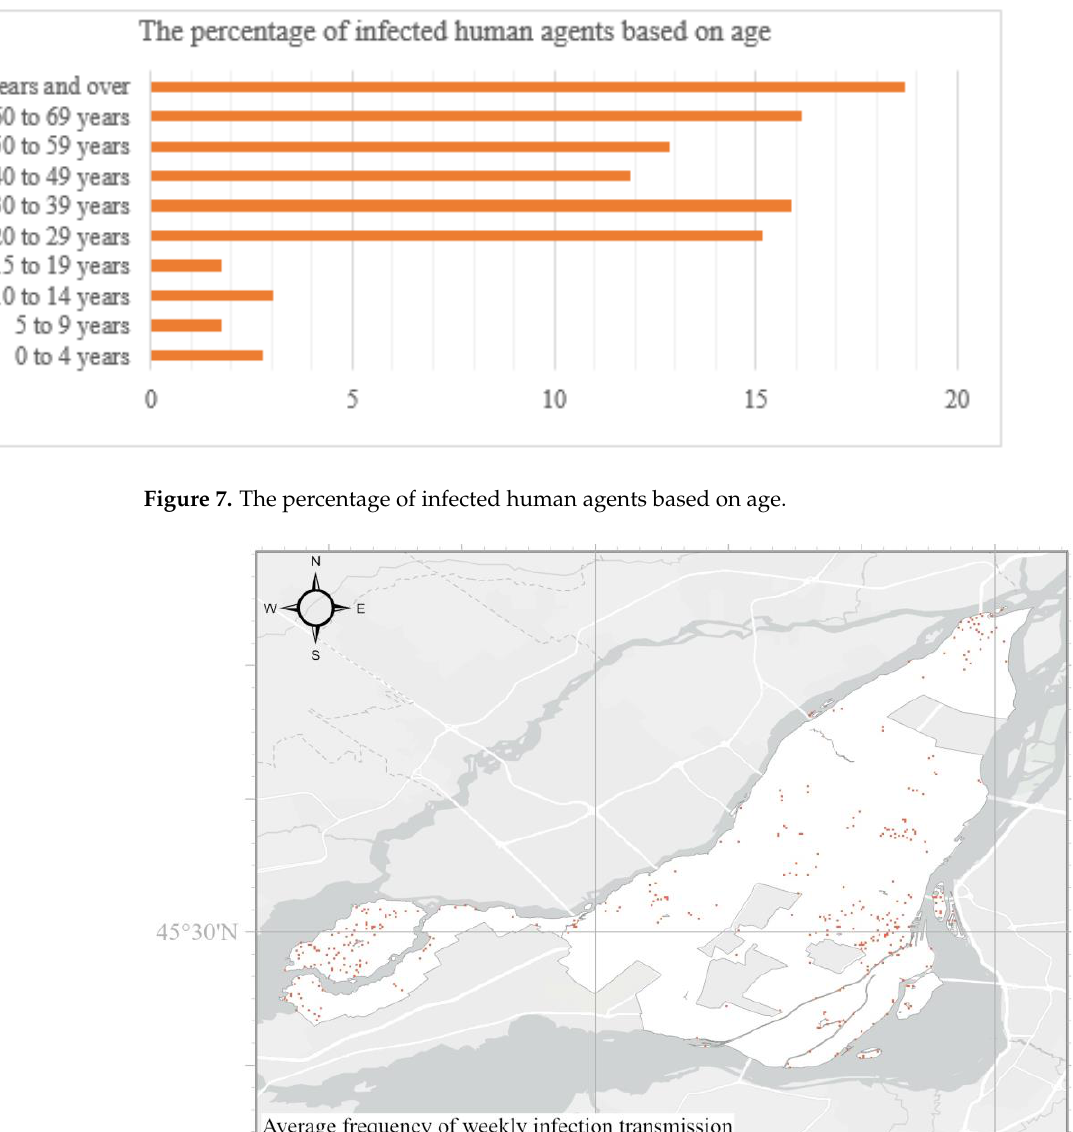
Figure 6. The momentum number of human agents in each status over the simulation (the result of an example run); each agent is a representative of 100 people.